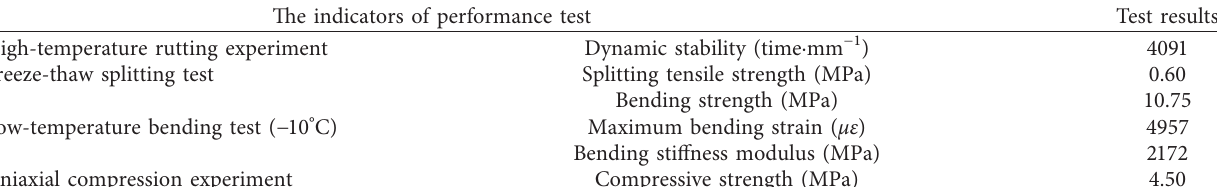
Table 1: The indicators of large-void basalt fiber asphalt mixture (fiber content was 0.3%).